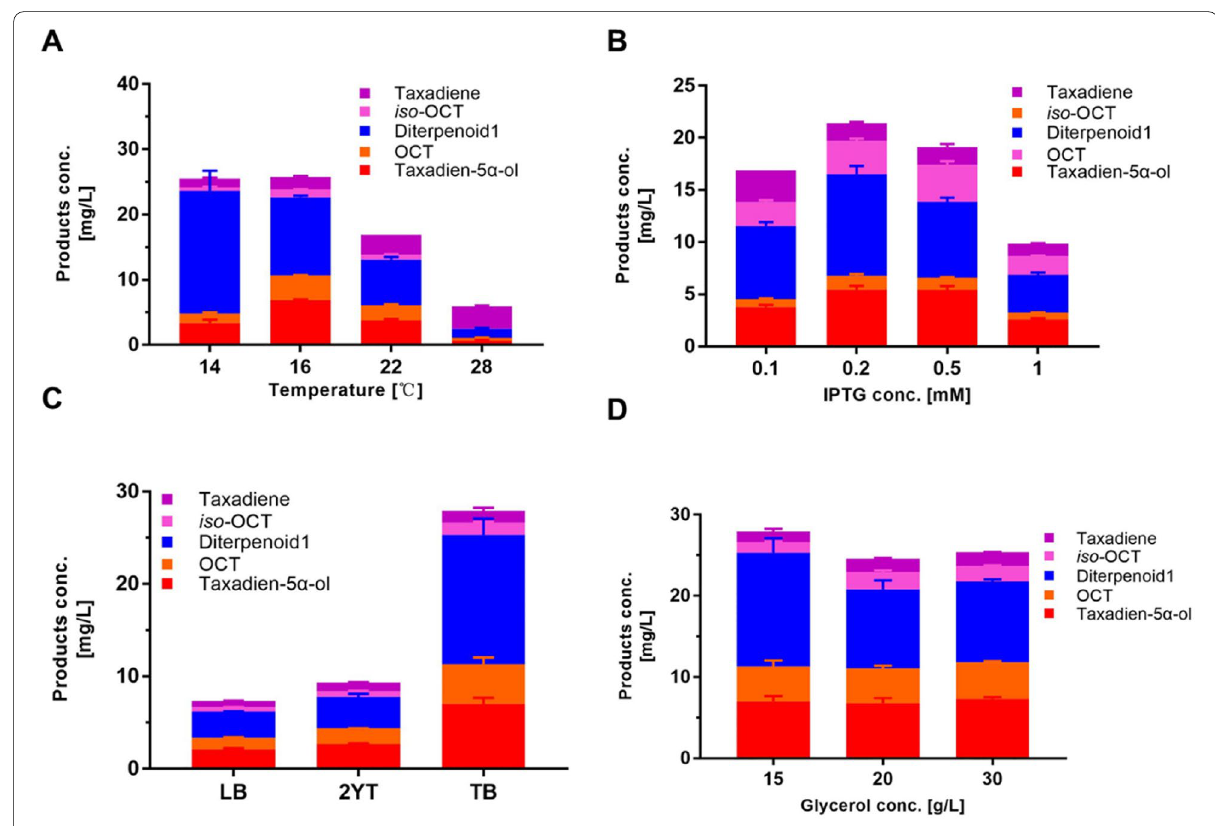
Fig. 5 Optimization of the fermentation conditions for TaolV1 strain. A Temperature; B IPTG concentration; C culture medium; D glycerol